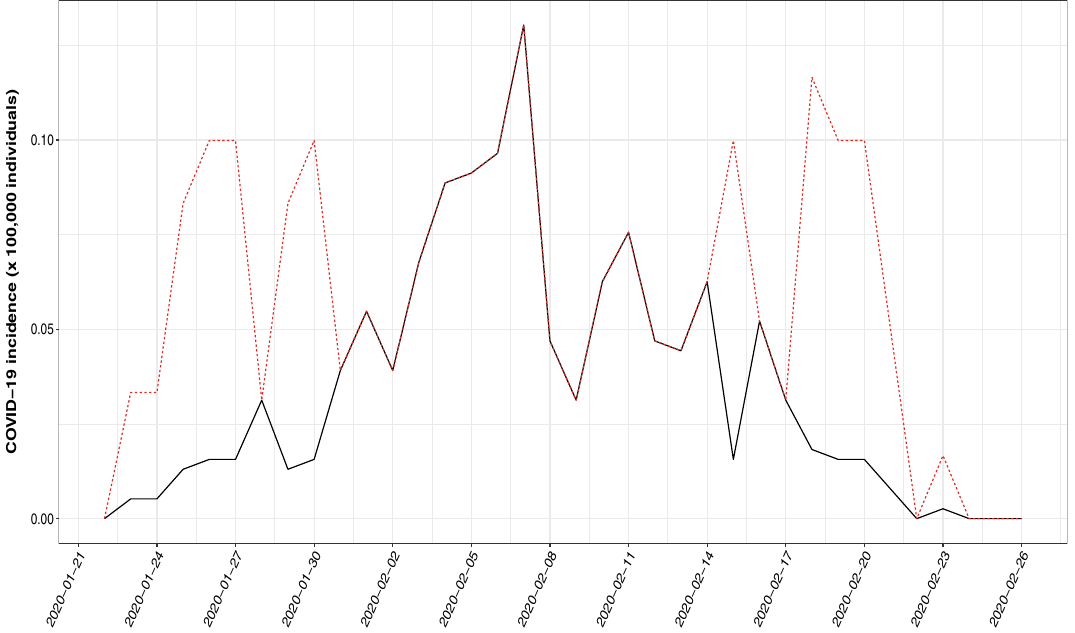
Figure 3. Registered (black solid line) and estimated (red dotted line) COVID-19 incidence in the region of Heilongjiang in the period 2020/01/22–2020/02/26.